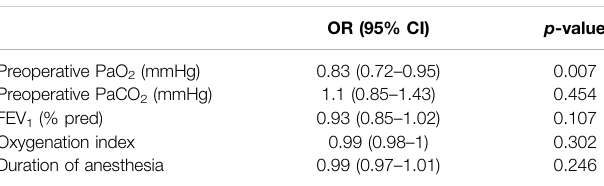
TABLE 3 | Risk factors for respiratory failure.